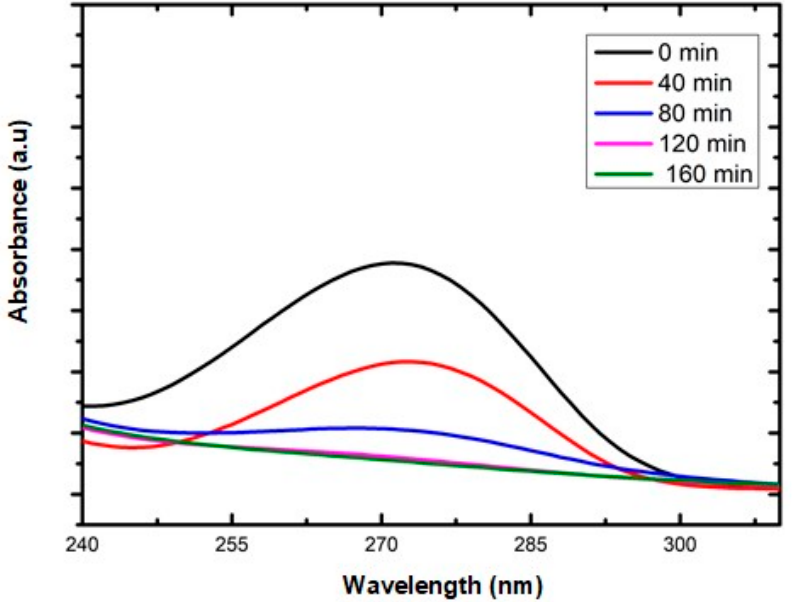
Figure 5. UV spectra of 10 ppm ca ff eine degradation using 35 mg catalyst.